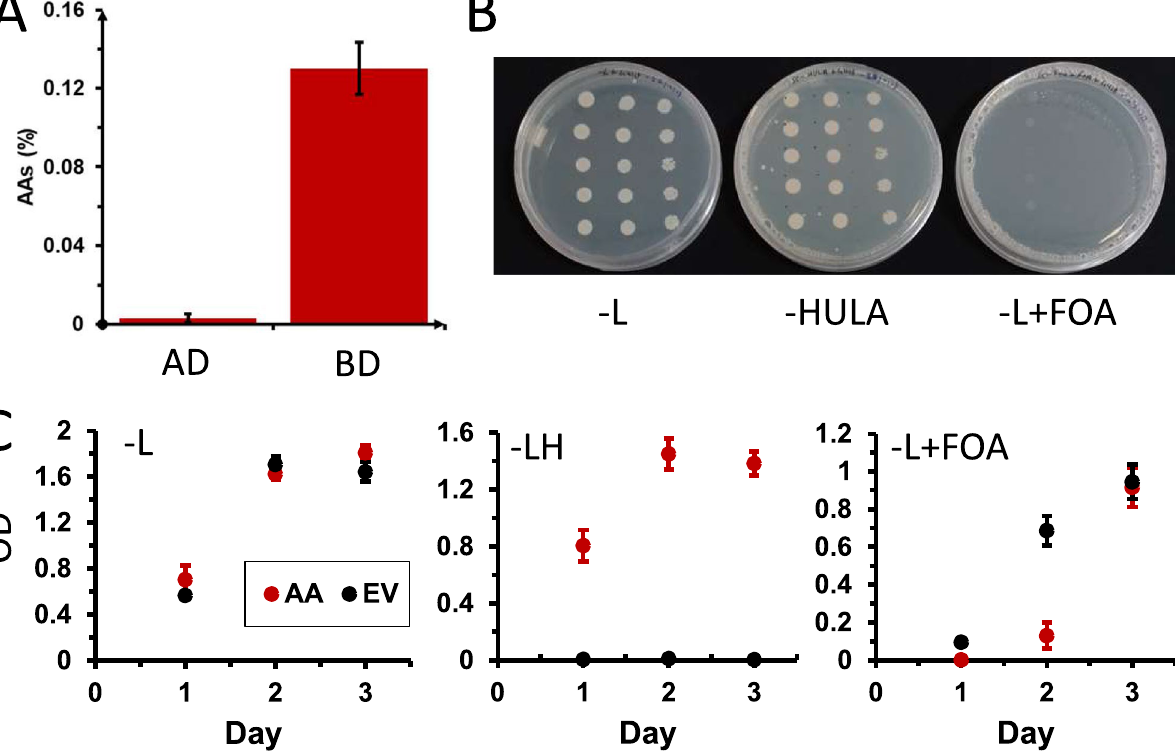
Figure 2. Quantification of auto activators in AD and BD and removal by 5-FOA treatment in liquid cultures. ( A ) Percentage of the auto-activators present in AD and BD libraries. The error bars indicate standard deviation. ( B ) Growth of the five AAs from the BD library on –L (left), –HULA, and –L + FOA (right). AA1-5 (rows) were spotted in three serial dilutions (1:1, 1:10, 1:100, columns) and grown for 3 days. ( C ) Growth of the five AAs from the BD library (red points) and three empty vector (EV, black points) controls in liquid –L (left), –LH, and –L + FOA